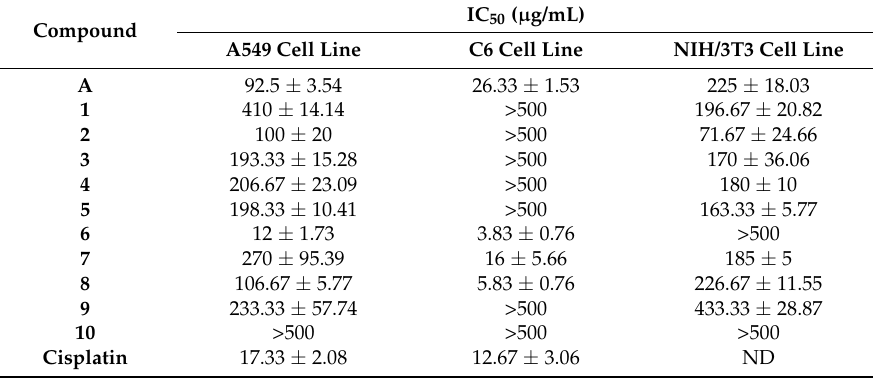
Table 1. IC 50 values of the compounds against A549, C6, and NIH/3T3 cells for 24